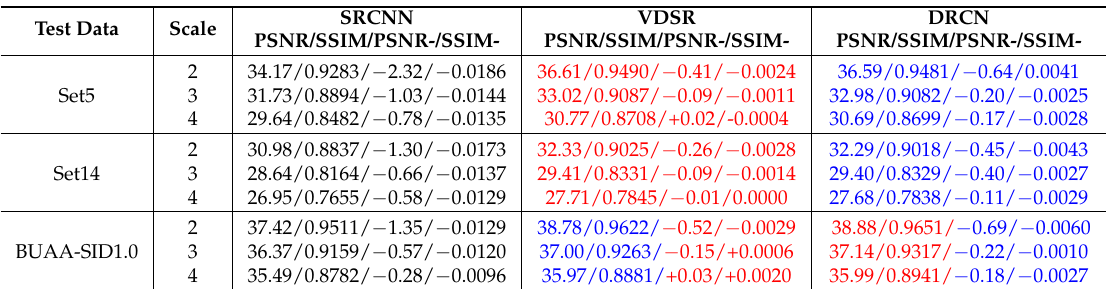
Table 6. Multiple scale super-resolution results of networks trained on T91 dataset. The red font indicates the best performance, while the blue font indicates the second best.